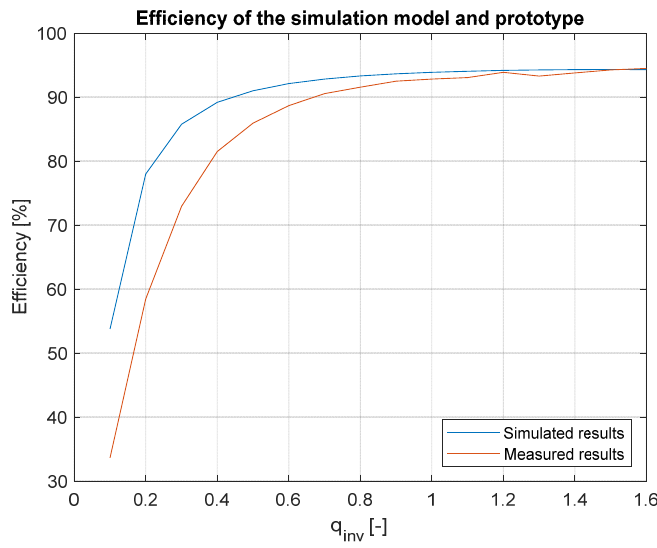
Figure 15. Compared efficiency (simulation vs. measurement).